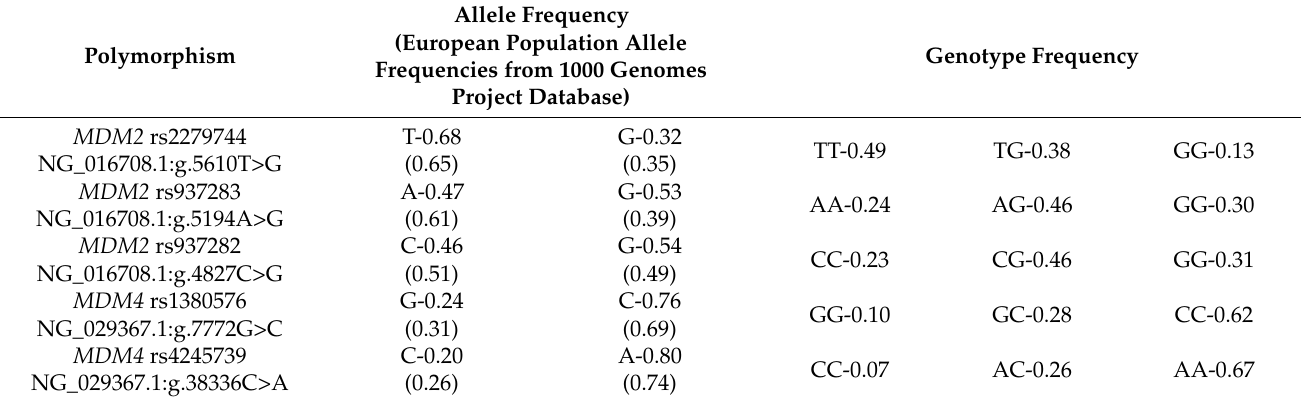
Table 4. Allele and genotype distribution of MDM2 and MDM4 polymorphisms in the study group.